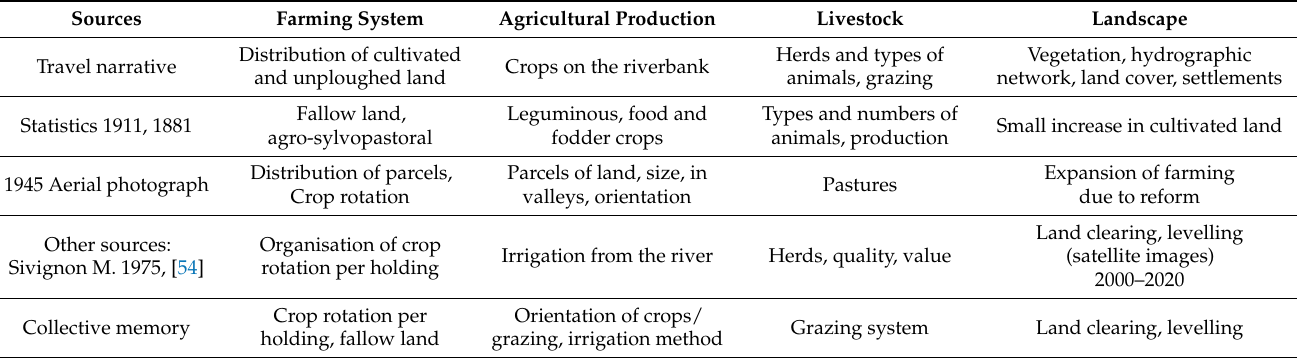
Table 1. Categorisation of 19th-century landscape